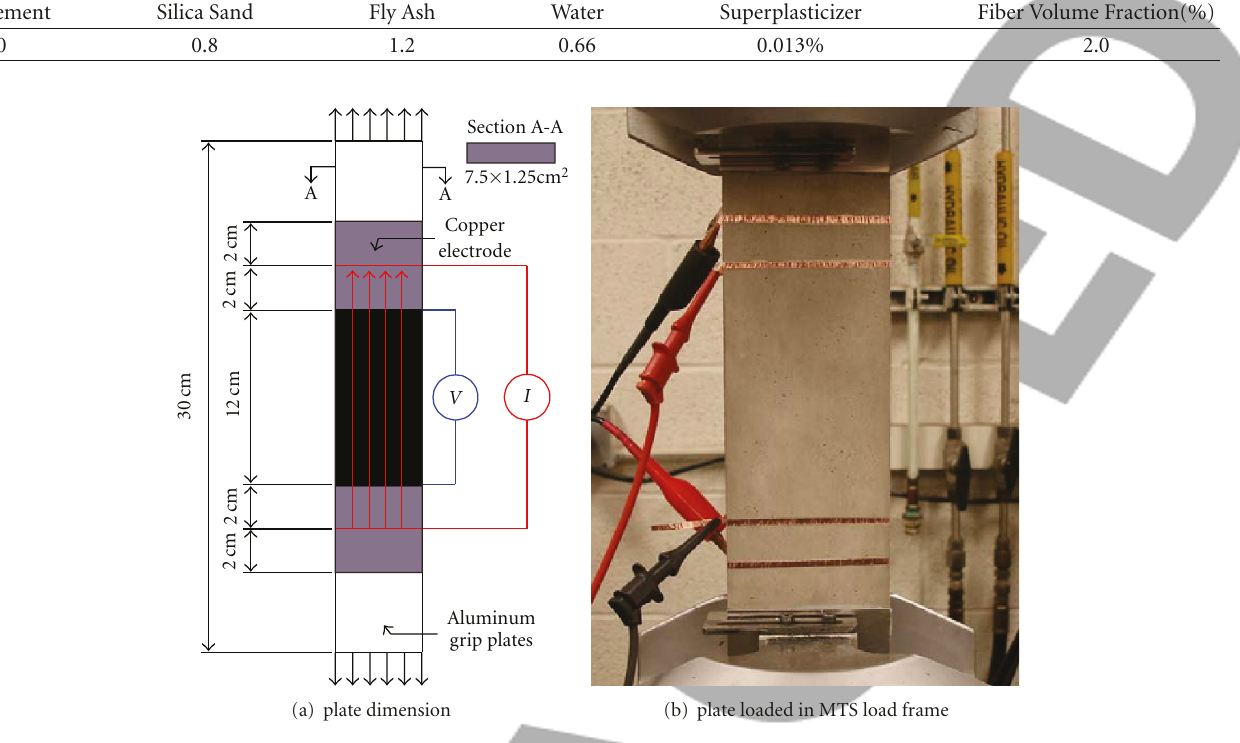
Figure 5: ECC plate element for piezoresistivity